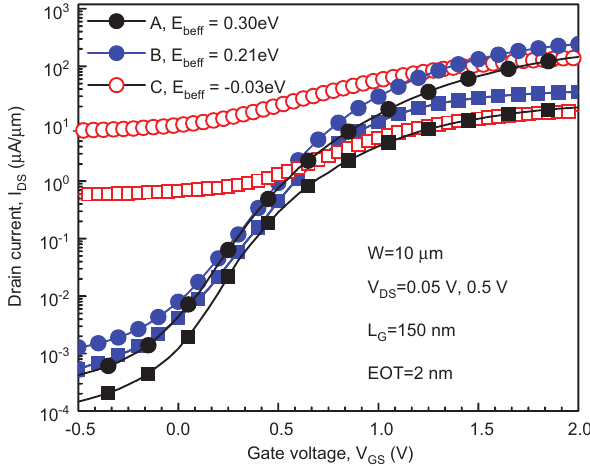
- V ) of TFET d g = 0.21 beff